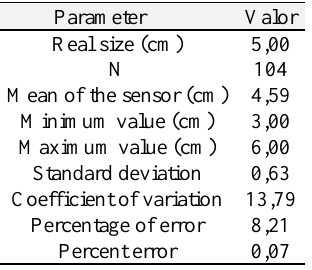
Table 5. Results obtained for a 5 cm water